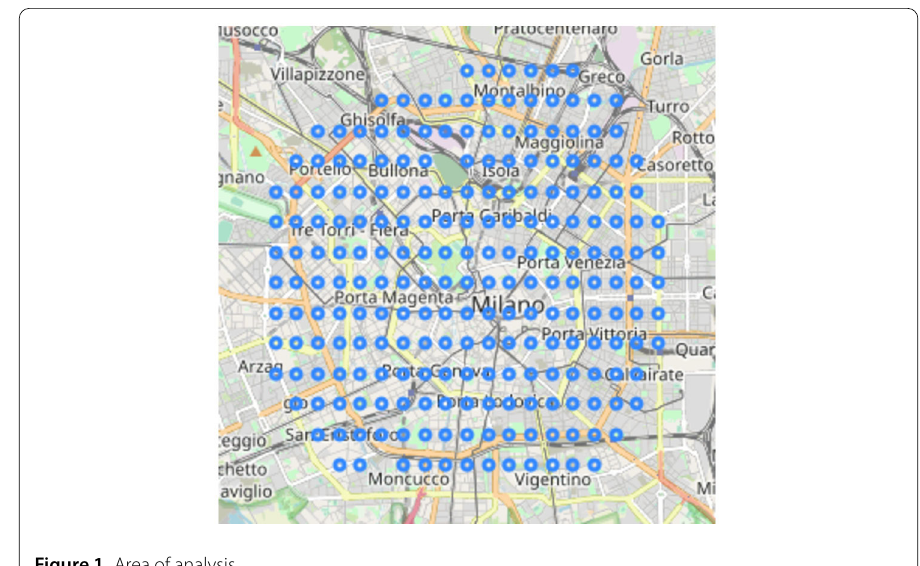
Figure 1 Area of analysis